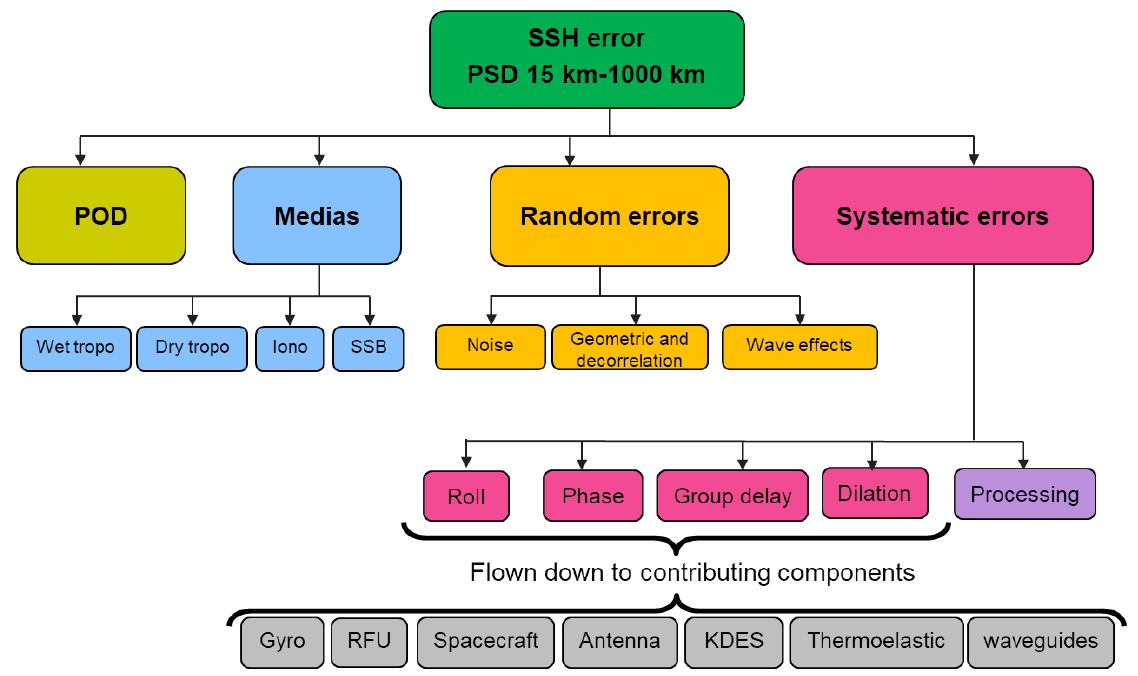
Figure 1. Schematics of the error breakdown for SWOT. The total error (green box) is the sum of many components. The systematic errors discussed in this paper are in the pink box. They have different origins (smaller pink boxes) and each SWOT subsystem (grey box) has an allocation, which is verified by the Project through simulation or hardware testing.